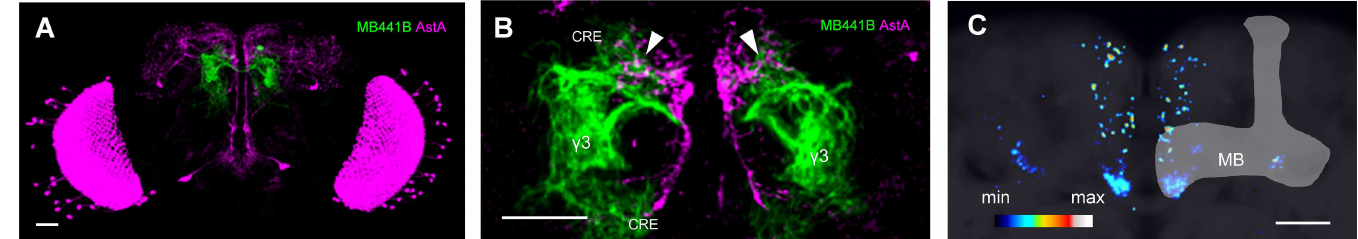
Fig 5. Allatostatin A neurons project to PAM- γ 3. (A) Expression patterns of AstA- (magenta) and MB441B-GAL4 (green) neuronsaligned in a standard brain. Three brainsfor each line were examined,which essentiallyexhibitedthe same overlappattern. (B) Magnification of (A) aroundthe MB γ lobe. These processesoverlap in the crepine (CRE; arrowheads). (C) ComplementaryGFP moieties are expressedin the AstA and PAM- γ 3neurons. The GRASP signalsfrom six animalsare averagedand pseudocolor-coded.Gray shades indicatethe MB. Scale bar, 20 μ